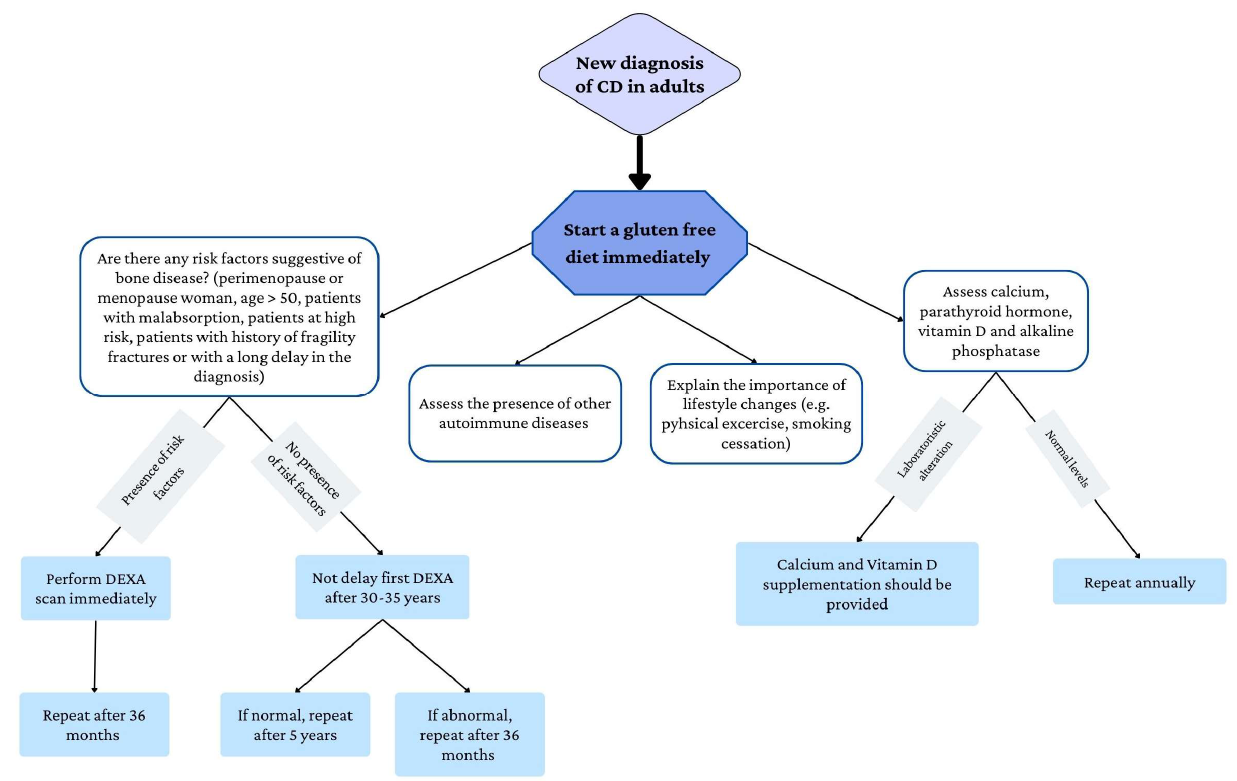
Figure 2. Flow chart of the management of bone health in CD patients.